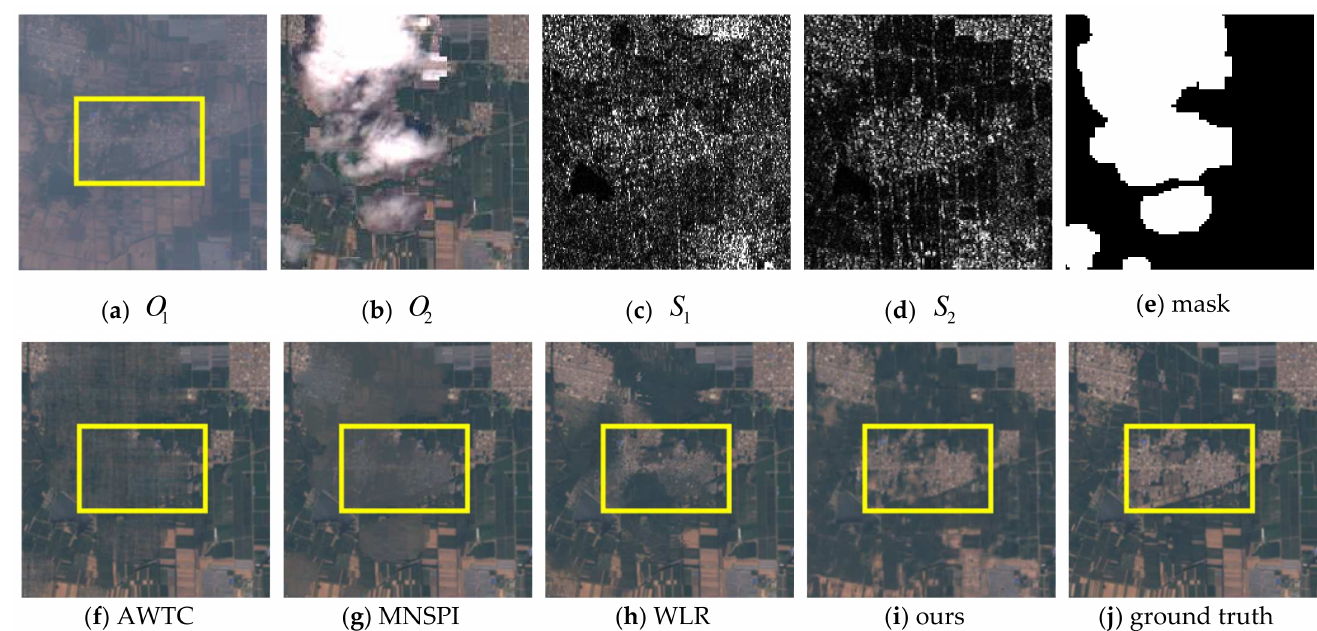
Figure 3. Magnified area 1 of simulation experiment results. Area boxed in yellow is the town area. In O 1 , the town area and the surrounding area share the same spectral information while in the ground truth they are different. Only the proposed method can differentiate the town area and the surrounding